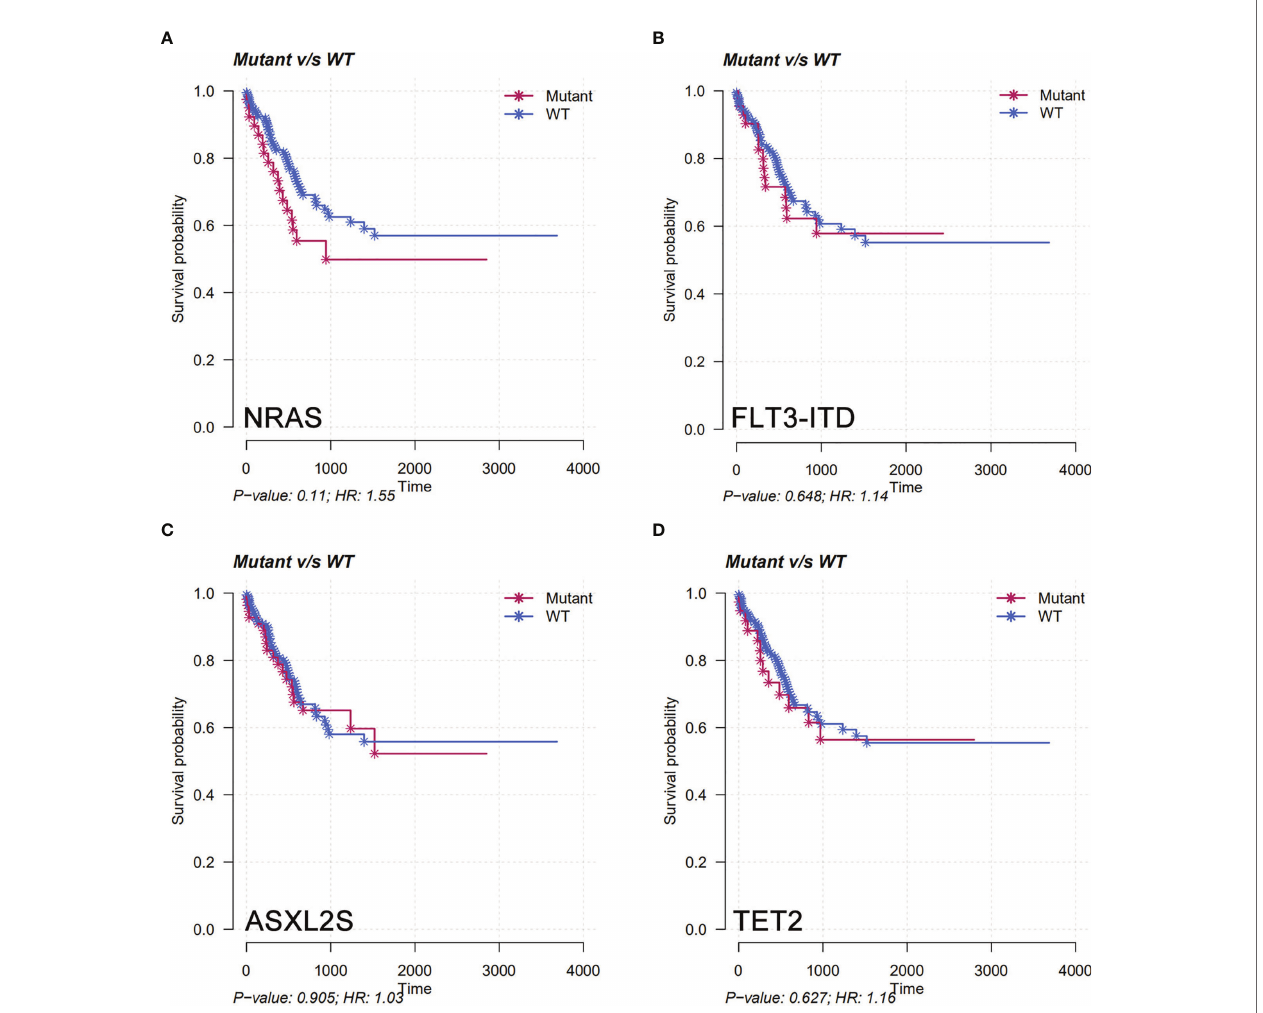
FIGURE 4 | Overall survival (OS) and recurrence-free survival (RFS) in the entire patient group according to different molecular characteristics of AML1-ETO. (A) Mutation with NRAS. (B) Mutation with FLT3-ITD. (C) Mutation with ASXL2S. (D) Mutation with